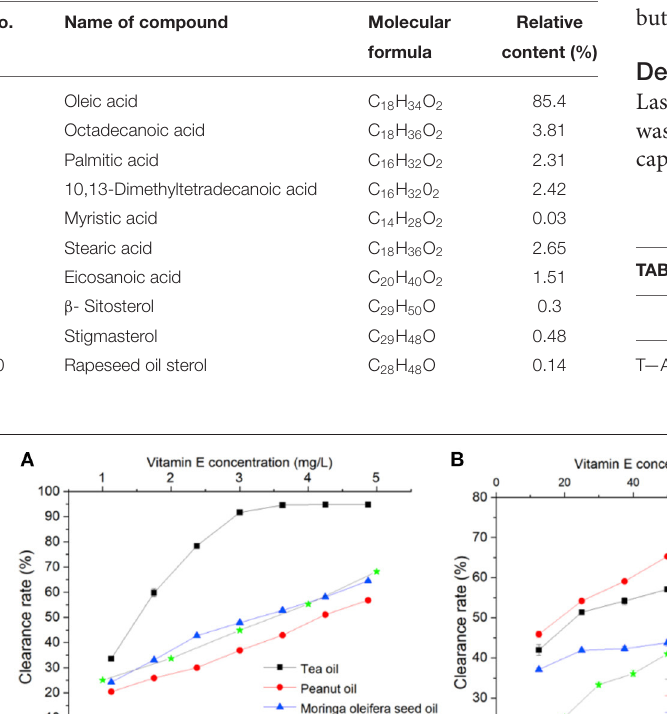
TABLE 5 | Composition of Moringa seed oil.